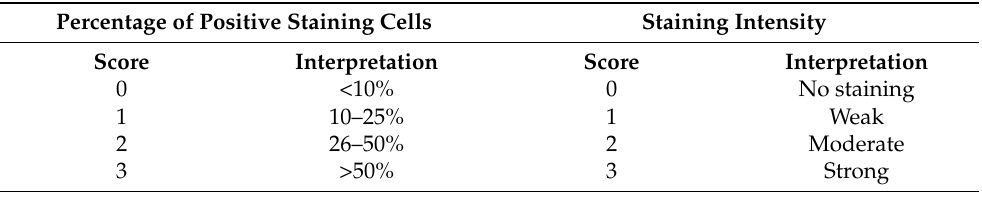
Table 3. Scoring criteria of immunostaining assay for VEGF-A, VEGFR-1 and